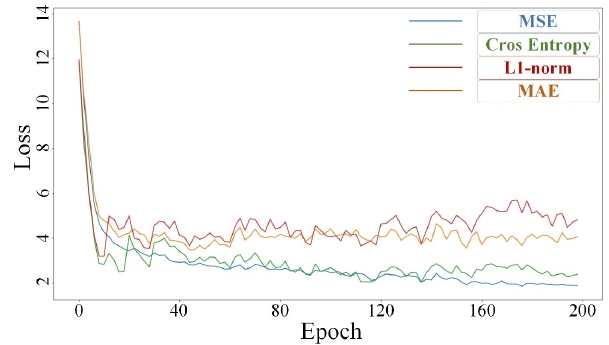
Figure 6. The training results of the proposed Res-LSTM model with different loss functions.